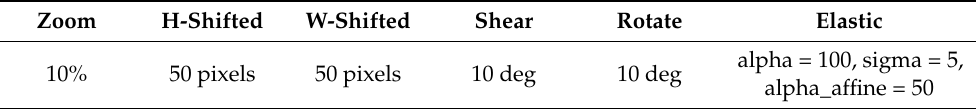
Table 3. Parameters used in each type of image transformation used for data augmentation.